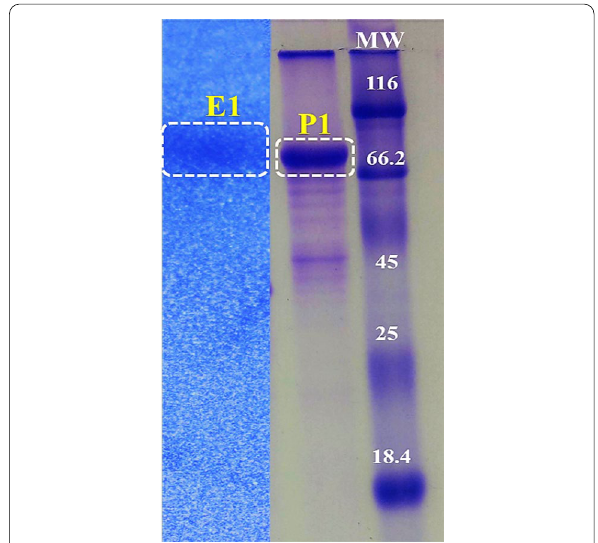
Fig. 4 Characterisation of chitinolytic activity of protein extract of Alternaria alternata VLH1 (Lane 1. (E1) chitinolytic activity on 2% agarose gel with 0.2% colloidal chitin as substrate, Lane 2. Chitinase enzyme band isolated from crude protein extracts of A. alternata VLH1, Lane 3. Molecular weight